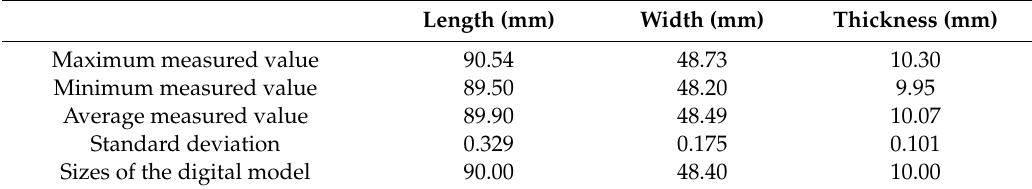
Table 2. The size of 3D-printed